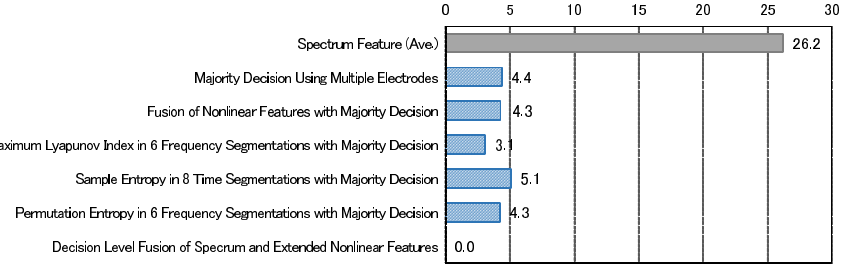
Figure 14. Summary of the obtained